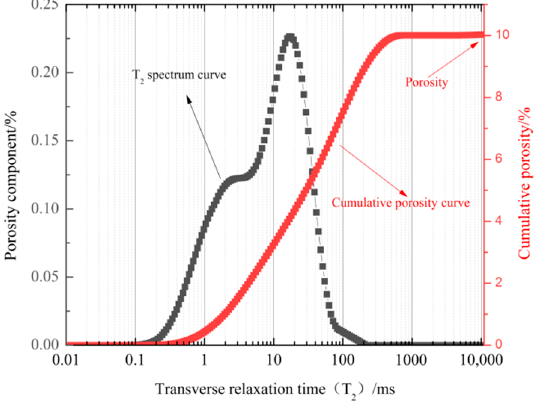
Figure 2. T 2 distribution and cumulative porosity curve of sandstone.